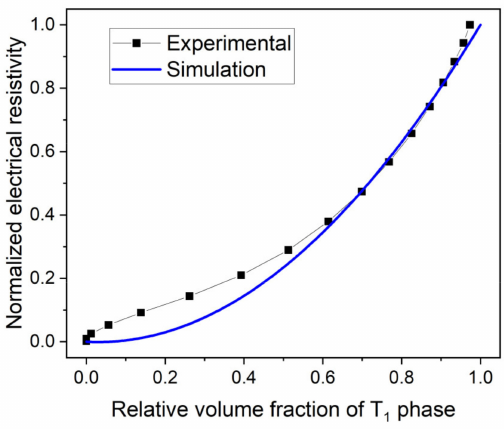
Figure 3. The evolution of simulated and experimental normalized electrical resistivity vs. the relative volume fraction of the T 1 phase measured by